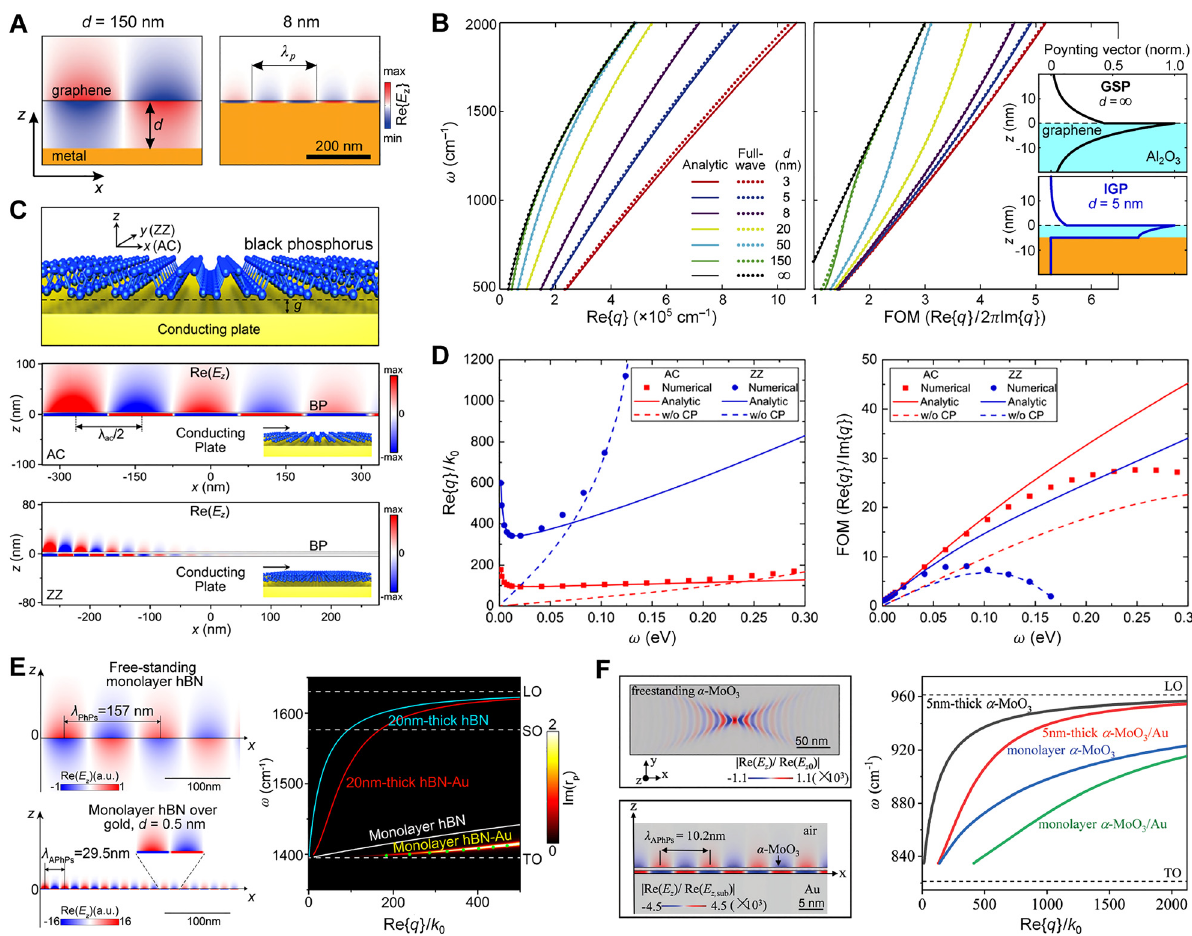
Figure 2: Numerical analysis of image polaritons. (A) Field profile of an IGP: a thinner spacer leads to a more compressed IGP attaining shorter wavelengths ( E F = 0.44 eV). (B) Dispersion (left) and FOM (right) of mid-IR IGPs in the structure shown in (A) as a function of d ; the inset in the right panel shows the pro fi le of the Poynting vector in the direction of propagation for GSP and the IGP in graphene on an alumina substrate. (A) and (B) Adapted from [42] (inset in (B) is addedbytheauthors).LicensedunderaCreativeCommonsAttribution.(C)Schematicillustrationoftheatomicstructureofblackphosphorus (top), and fi eld pro fi les of image plasmons propagating along armchair (middle) and zig-zag (bottom) crystal axes. (D) Dispersion (left) and FOM (right) of image plasmons in black phosphorus ( d = 5 nm). (C) and (D) Adapted with permission from [43]. Copyright 2018, American Chemical Society. (E) Field pro fi les (left) and dispersion (right) of the phonon-polaritons in free-standing monolayer hBN crystal, and that of the image mode emerging when hBN is placed close to a metal plate. Adapted with permissionfrom [45]. Copyright 2020, American Chemical Society.(F)Fieldpro fi les(left)anddispersion(right)ofphonon-polaritonsinafree-standingmonolayer α -MoO 3 crystalandtheimagemodein monolayer α -MoO 3 above a goldplate; notethat dueto the in-planeanisotropy of monolayer α -MoO 3 , thephonon-polariton modewould have a different propagation direction in different Reststrahlen bands. Adapted with permission from [46]. Copyright 2021, Royal Society of